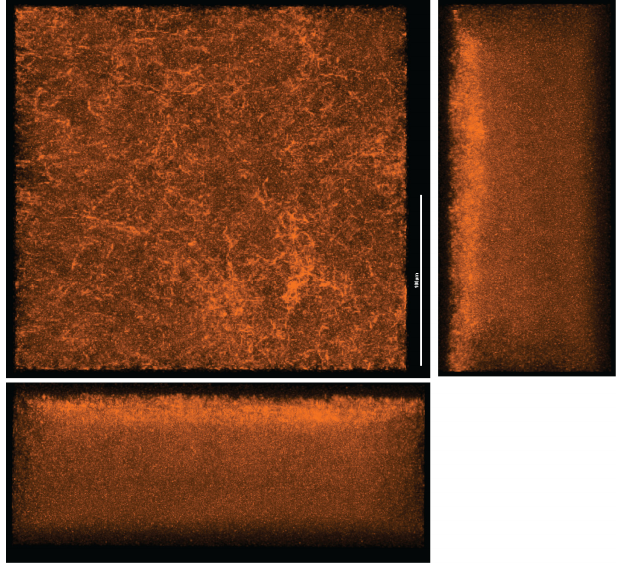
Figure 1. Monospecies biofilm of L. pneumophila labelled with the DNA stain Syto62. Scale bar represents 100 μ